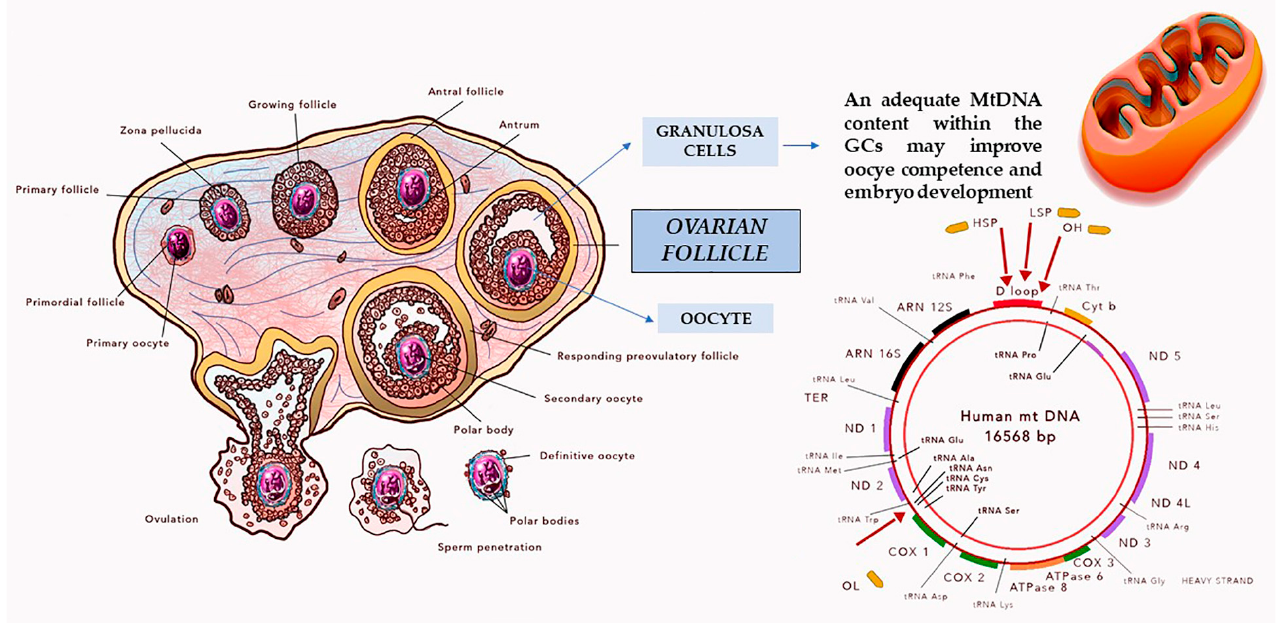
Figure 2. The oocyte competence is influenced by the communication between the oocyte and the surrounding granulosa cells (GCs). GCs express factors implicated in mtDNA replication and maintenance and therefore play a notable role in creating an adequate mtDNA pool during